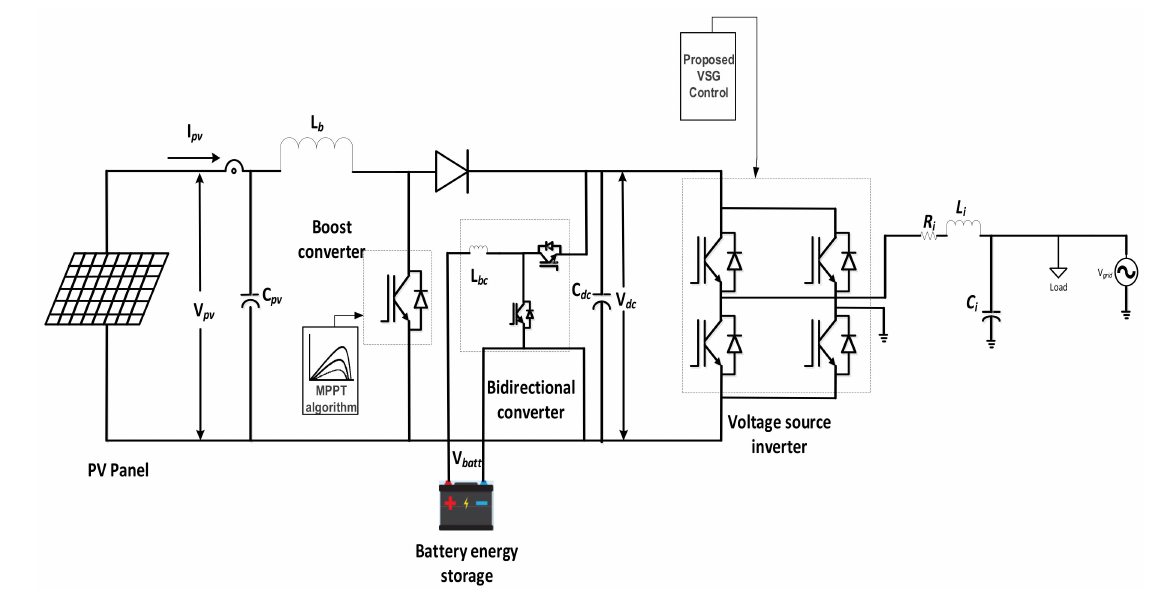
Figure 1. Test system considered for the multifunctional inverter control for PV.